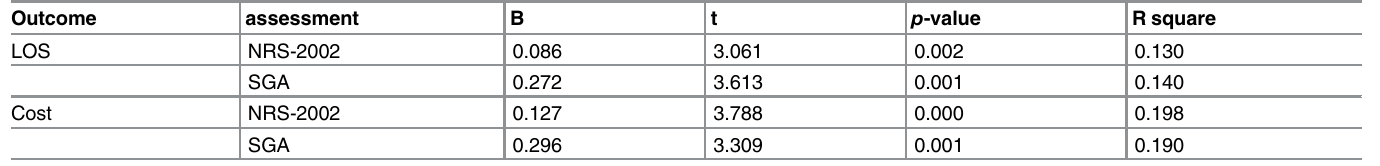
Table 3. Relationship between nutrition risk and LOS and